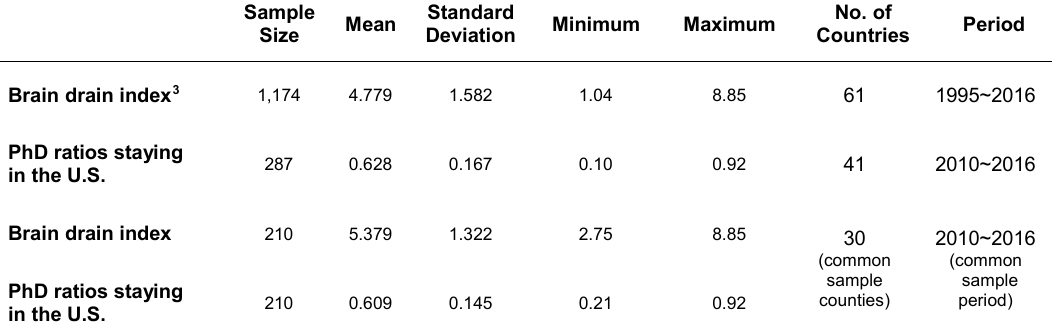
Table 1 . Descriptive statistics of brain drain index and share of doctorate recipients staying in the U.S.